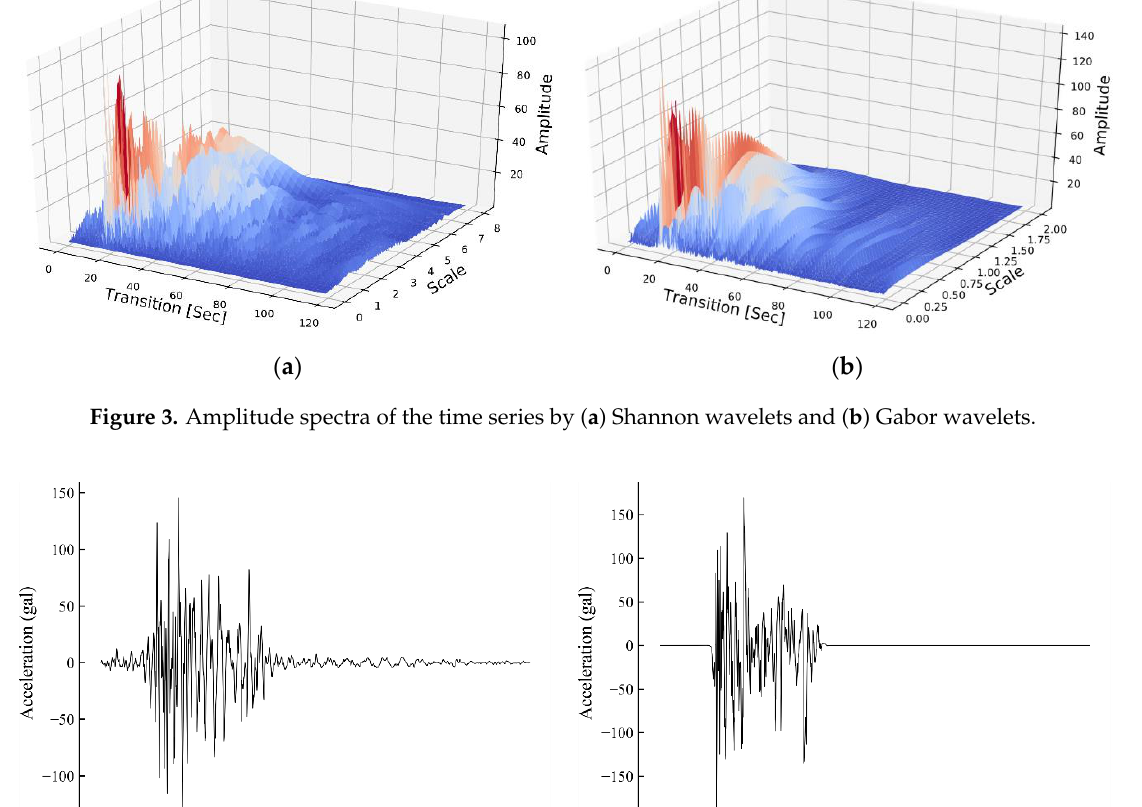
5 of 10 Figure 1. ( a ) Time and ( b ) frequency characteristics of complex Shannon wavelet basis. ( a ) ( b ) Figure 2. ( a ) Time and ( b ) frequency characteristics of Gabor wavelet basis. 4. Numerical Simulation